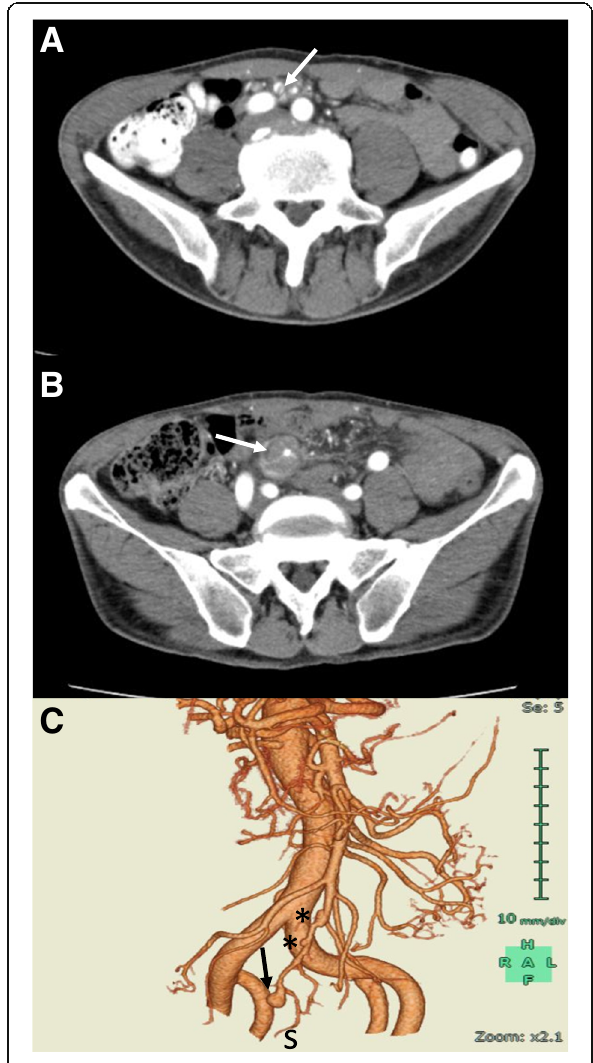
Fig. 1 Contrast-enhanced CT images on admission. a Superior mesenteric artery (white arrow) showing luminal stenosis and concentric intramural hematoma without extravasation. b A small intimal flap (white arrow) can be seen inside the SMA just proximal to the intramural hematoma. c CT angiograph showing two lesions (asterisks) with segmental dilatation proximal to the SMA aneurysm. A blind-sac aneurysm (black arrow) can also be seen. At this point, SMA blood flow distal (S) to the aneurysm is